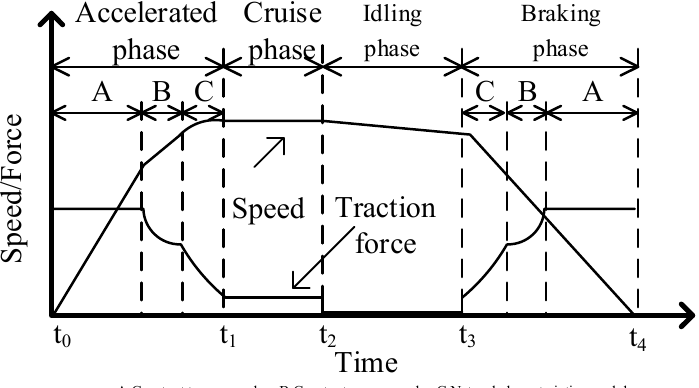
Figure 4. Rail transit operation characteristic model.